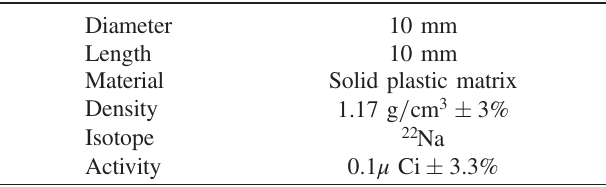
TABLE II. Specifications for 22 Na volume source.